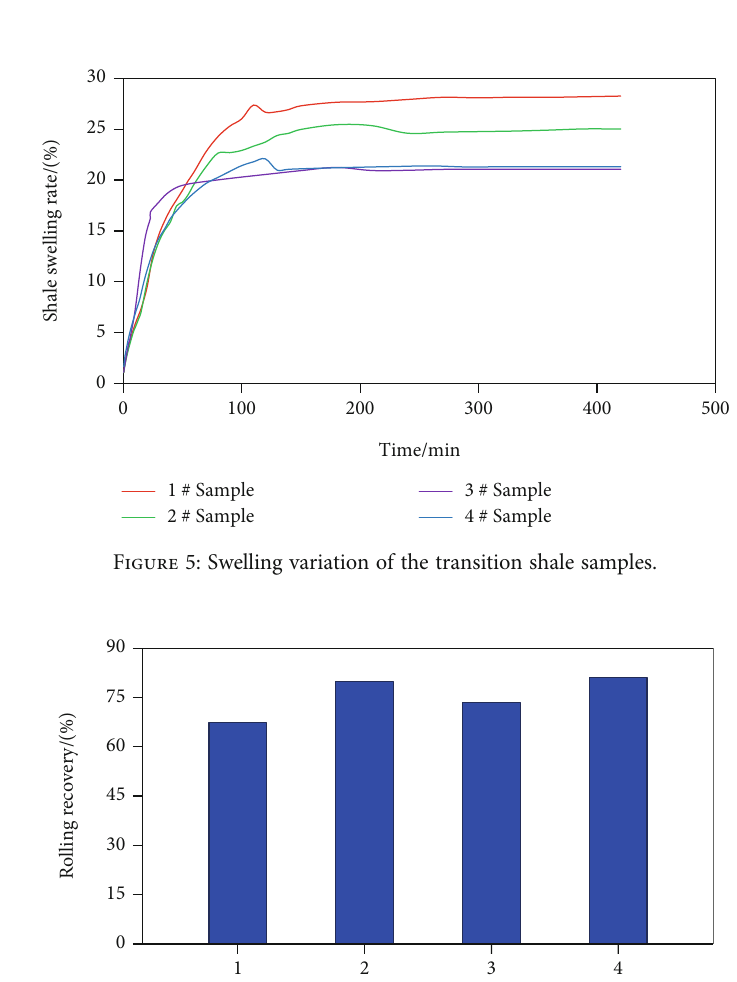
Figure 4: CEC values of the transition shale samples.